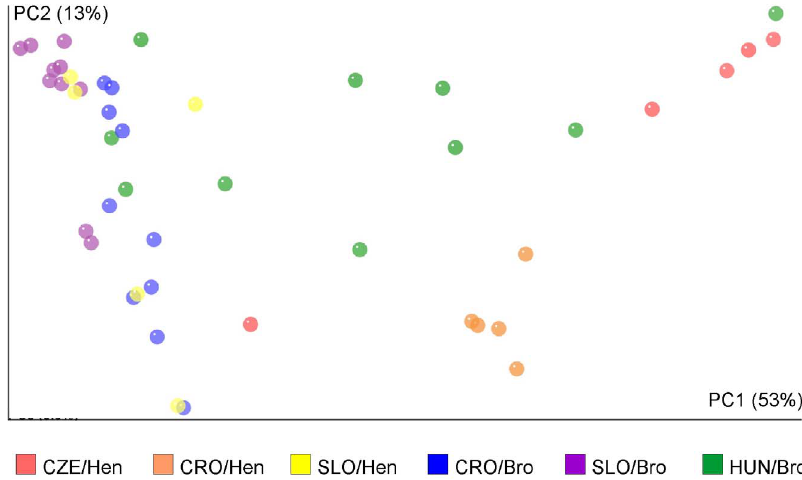
Figure 2. Microbiota diversity in fecal samples of broilers and hens. UniFrac analysis followed by PCoA showed that the two main factors explained 69% of the variability observed in the microbiota composition in poultry fecal samples. Slovenian egg layer microbiota were similar to samples originating from broilers and Hungarian samples of broiler origin clustered between broiler samples from Slovenia and Croatia, and egg laying hen samples from Croatia and the Czech Republic. SLO – Slovenia, CRO – Croatia, CZE – Czech Republic, HUN – Hungary, Hen - samples from egg laying hens, Bro – samples from broilers.